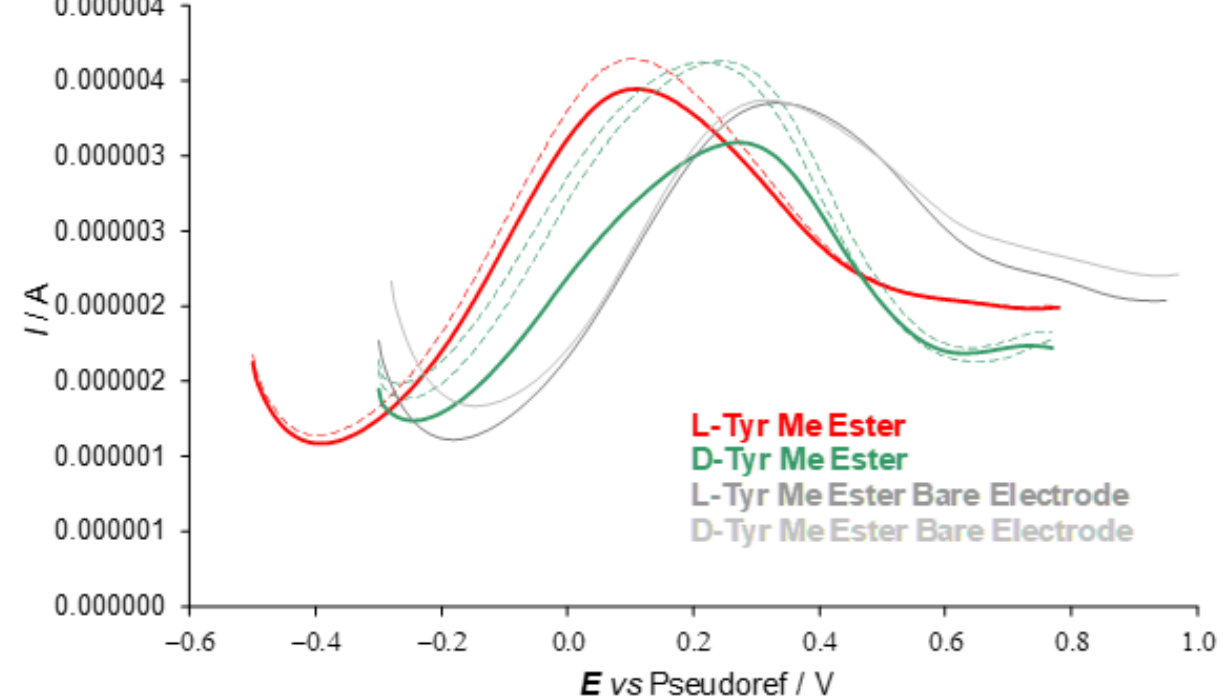
Figure 6. Enantiodiscrimination differential pulse voltammetry (DPV) tests with L-and D- tyrosine methyl ester, in achiral IL 1-butyl-3-methylimidazolium bistriflimide (BMIM)NTf 2 with ( P )- 2 or ( M )- 2 chiral additives. Repetitions are shown as dashed lines. IL: ionic liquid.